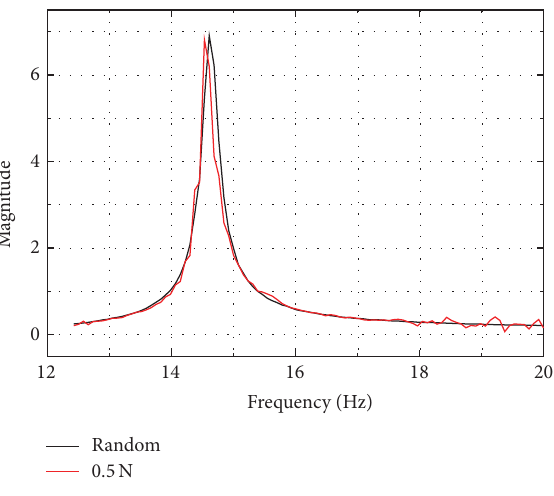
Figure 8: Measured linear FRF at sensor location A. Table 1: Measured first three natural